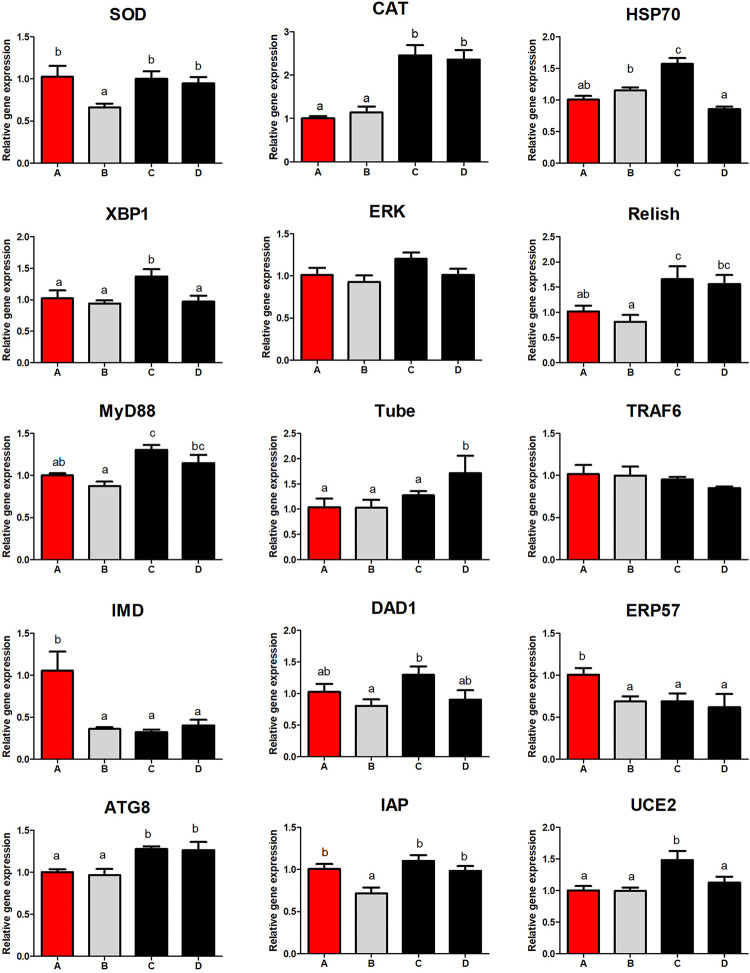
Effect of different diets on hepatopancreas immune response of Penaeus monodon. SOD, superoxide dismutase; IAP, inhibitor of apoptosis proteins; IMD, immune deficiency; ERP57, endoplasmic reticulum protein57; CAT, catalase; MyD88, myeloid differentiation primary response gene 88; ATG8, autophagy-related protein 8; ERK, extracellular signal-regulated kinase; HSP70, heat shock protein 70; XBP1, X-box binding protein 1; DAD1, defender against cell death 1; UCE2, ubiquitin conjugated enzyme 2.